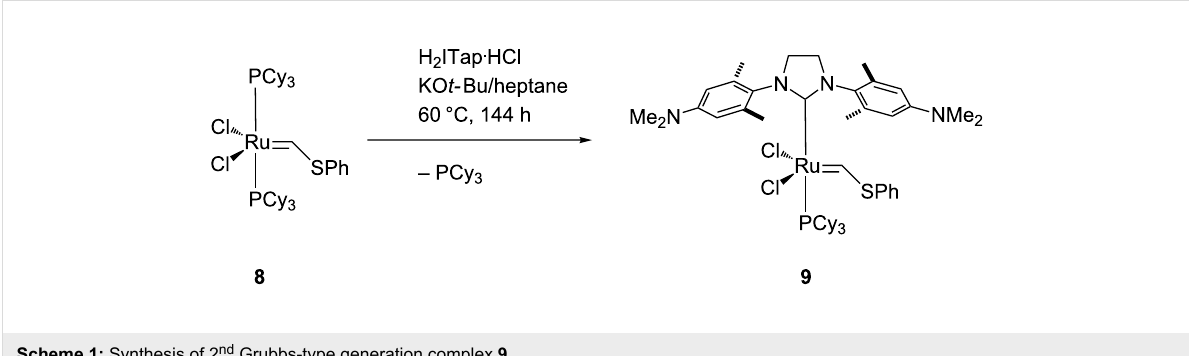
Scheme 1: Synthesis of 2 nd Grubbs-type generation complex 9